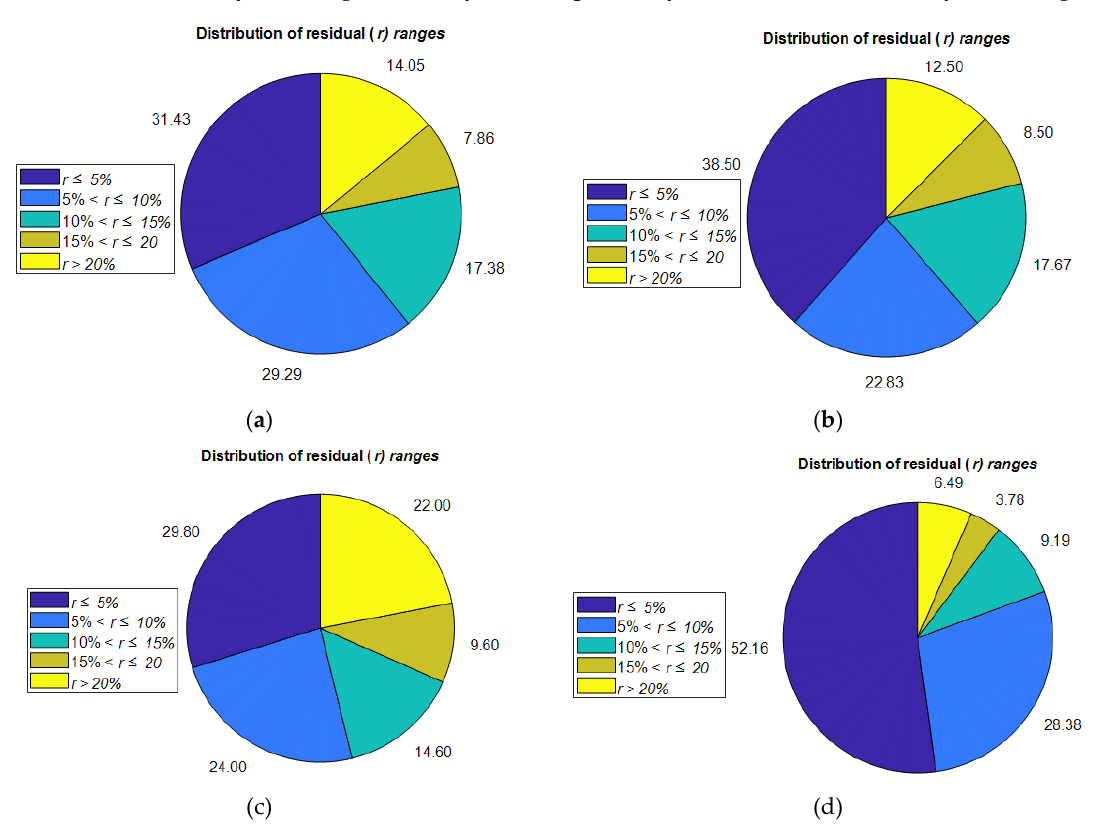
Figure 8. Distribution of the residual range: ( a ) the DNNR used for modeling Dataset 1, ( b ) the DNNR used for modeling Dataset 2, ( c ) the XGBoost used for modeling Dataset 3, and ( d ) the DNNR used for modeling Dataset 4.